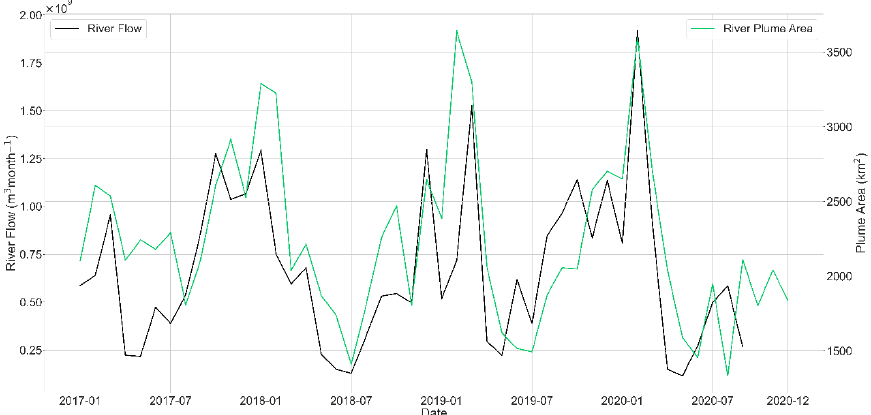
Figure 8. A timeseries of the river flow in the Liverpool Bay versus the river plume area between January 2017 and September 2020. October, November and December 2020 river flow measure- ments were unavailable at the time of the manuscript preparation.